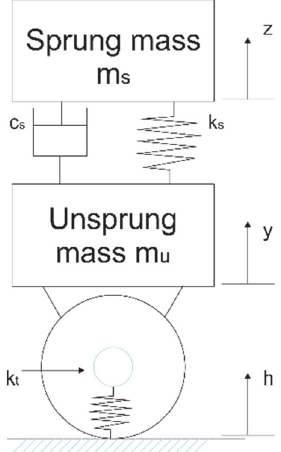
Figure 1: Quartenion car model [ 12 ]